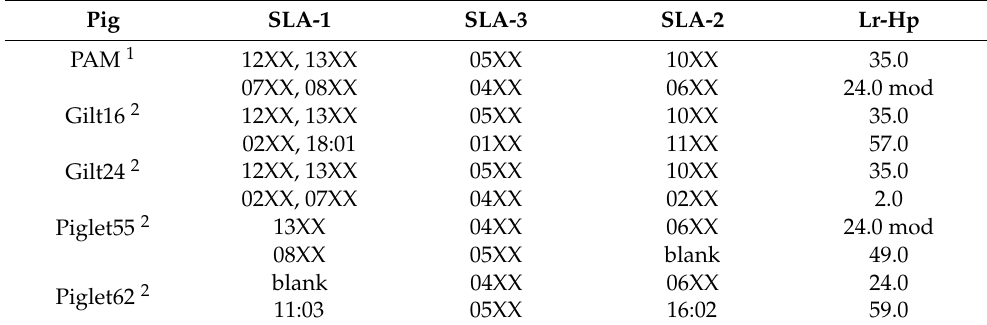
Table 3. SLA-I low-resolution haplotypes (Lr-Hp) of PAMs used for peptide isolation and PBMCs for in vitro restimulation.